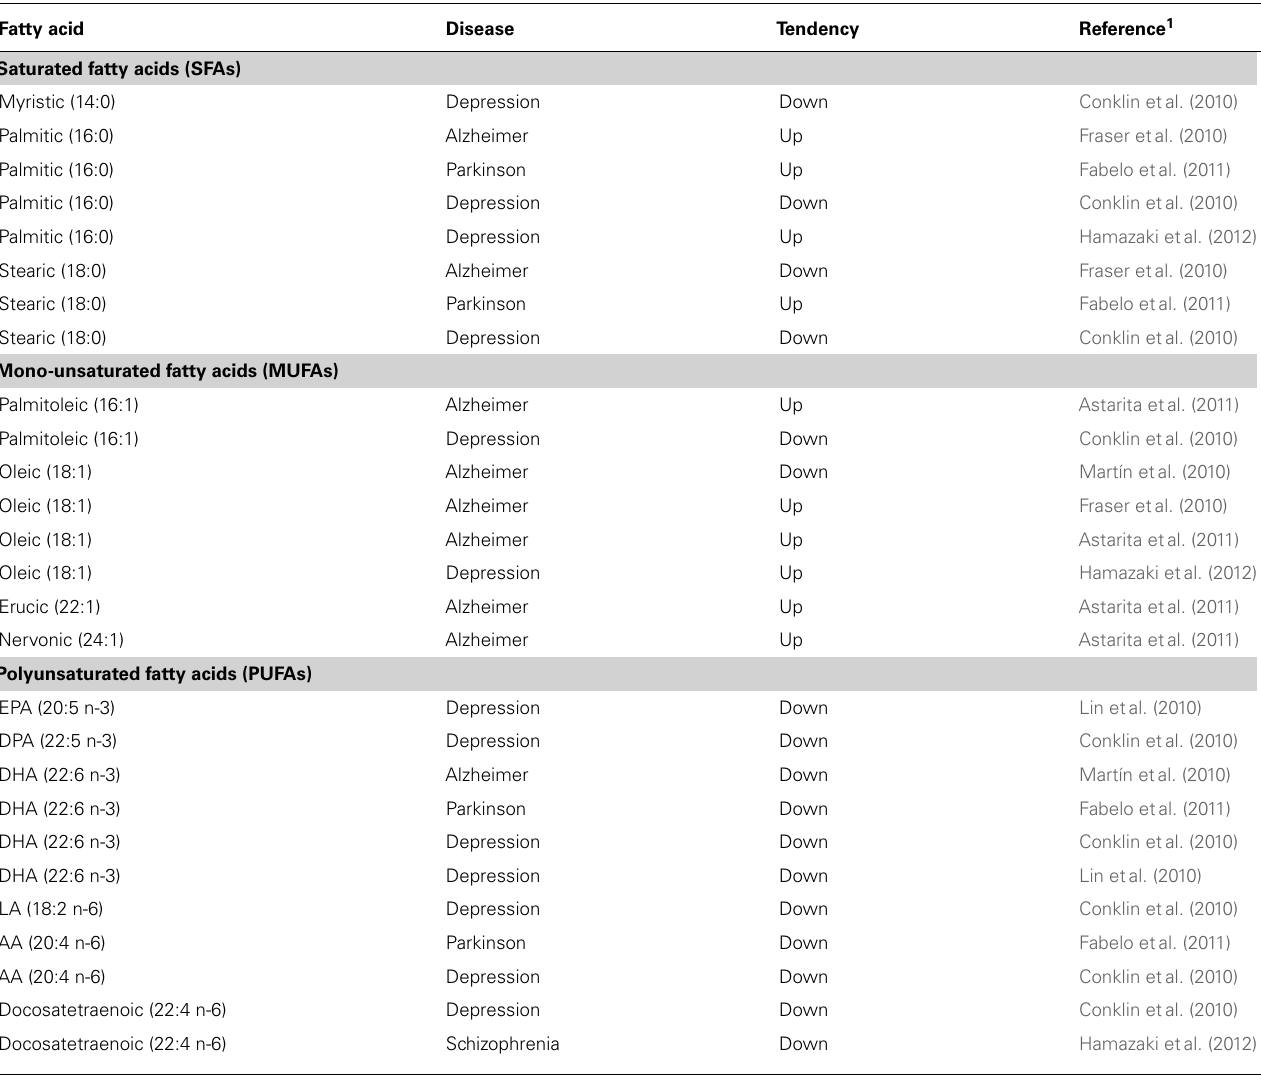
Table 2 | Changes in brain fatty acid composition in pathological conditions. Disease Tendency Reference